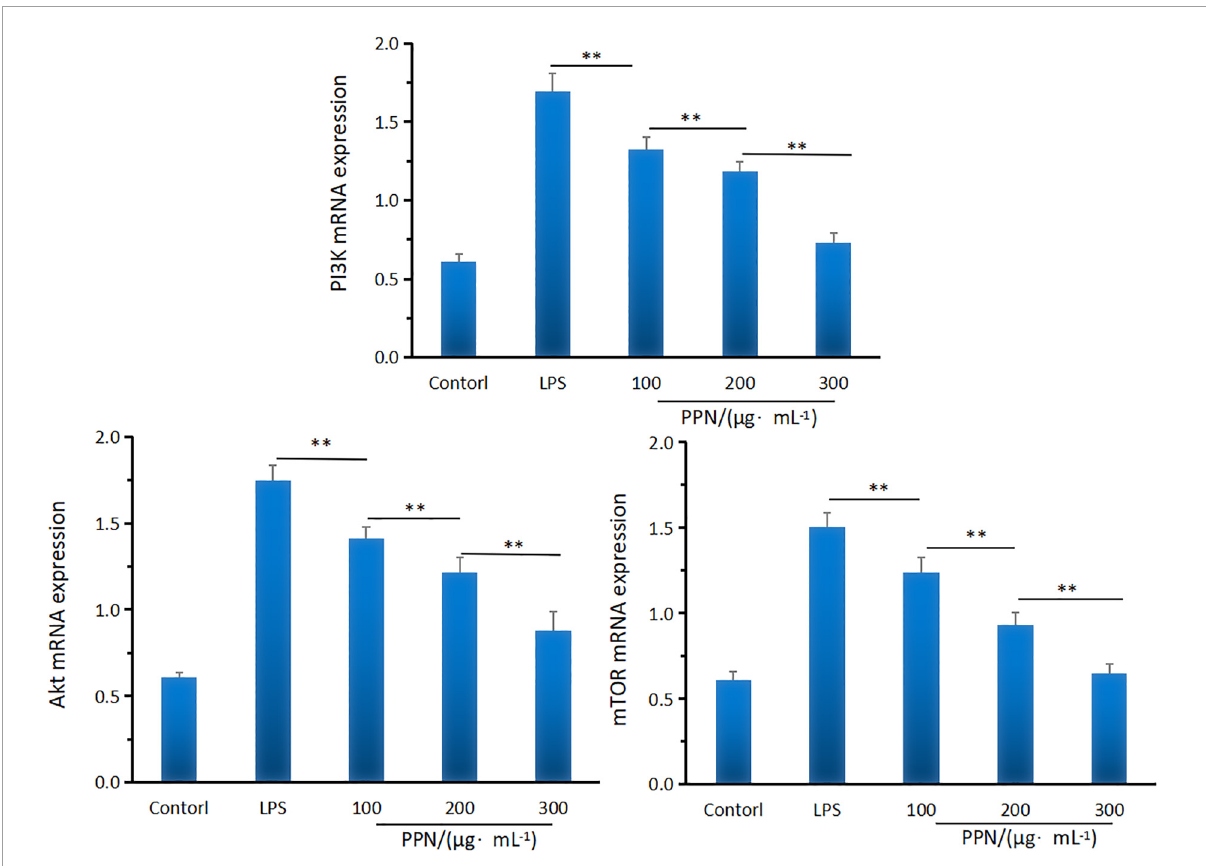
FIGURE7 The PI3KAktmTOR mRNA expression of SPN and PPN. **Indicates p <